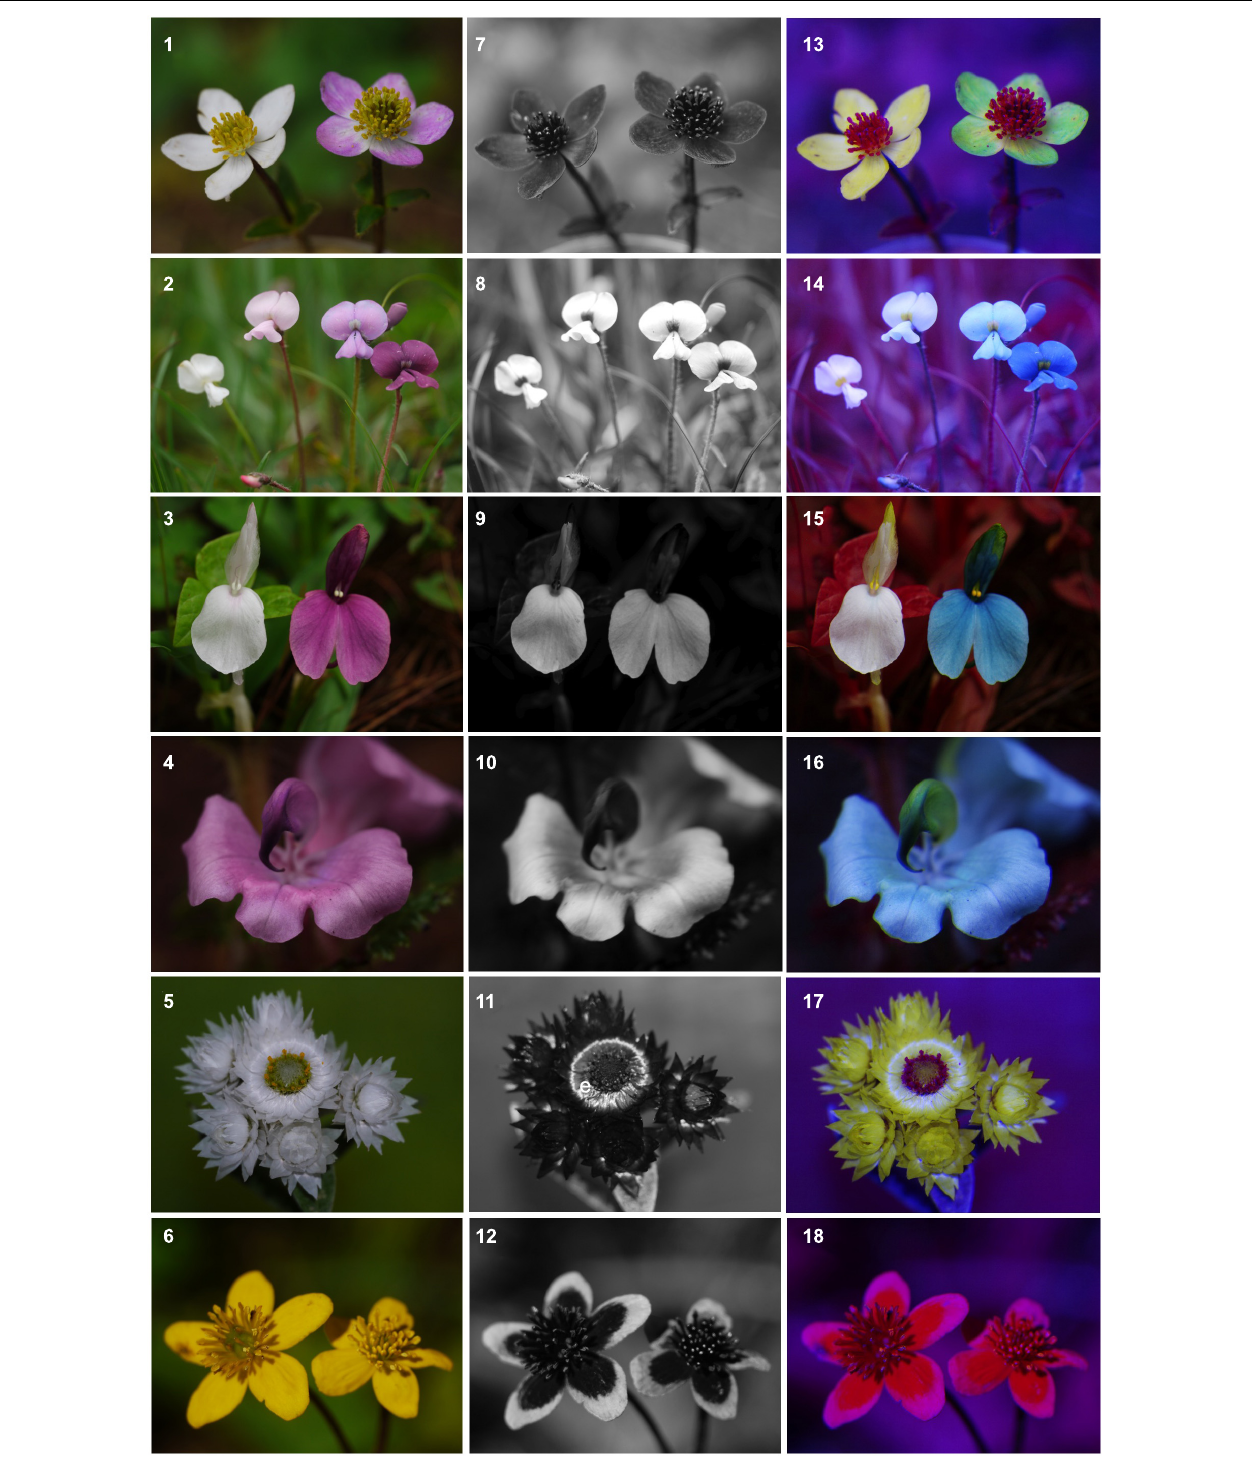
FIGURE 4 | Variation of flower color seen through the eyes of humans (1–6), in ultraviolet (7–12) and seen through the eyes of bees (12–18) using false color photography illustrating potential causes of neglected variation in flower color and bias in choice of study system. For a description of color representation see legend of Figure 3 . Illustrated species are by row from top to bottom: Anemone trullifolia var. holophylla (Ranunculaceae), Tibetia yunnanensis (Fabaceae), Roscoea schneideriana (Zingiberaceae), Pedicularis superba (Orobanchaceae), Anaphalis nepalensis (Asteraceae), Caltha palustris (Ranunculaceae).